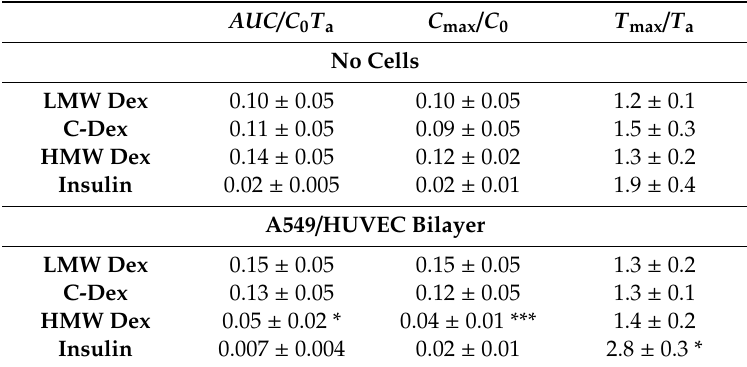
Table 2. Pharmacokinetic values for